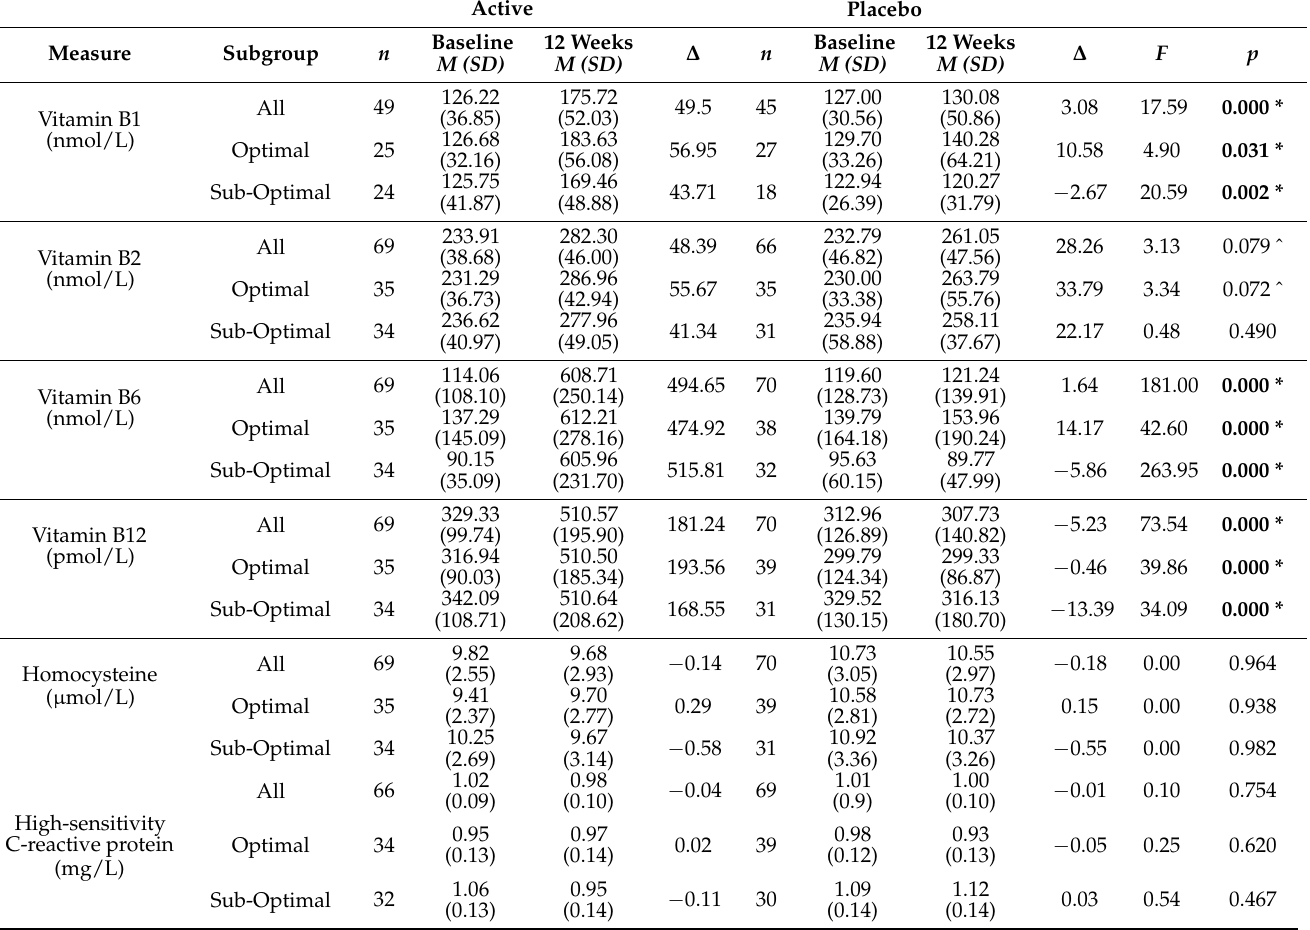
Table 4. Means, standard deviations, F value for treatment by time interaction and significance values from MMRMA analysis for blood levels of vitamin B and homocysteine at baseline and 12 weeks for active and placebo